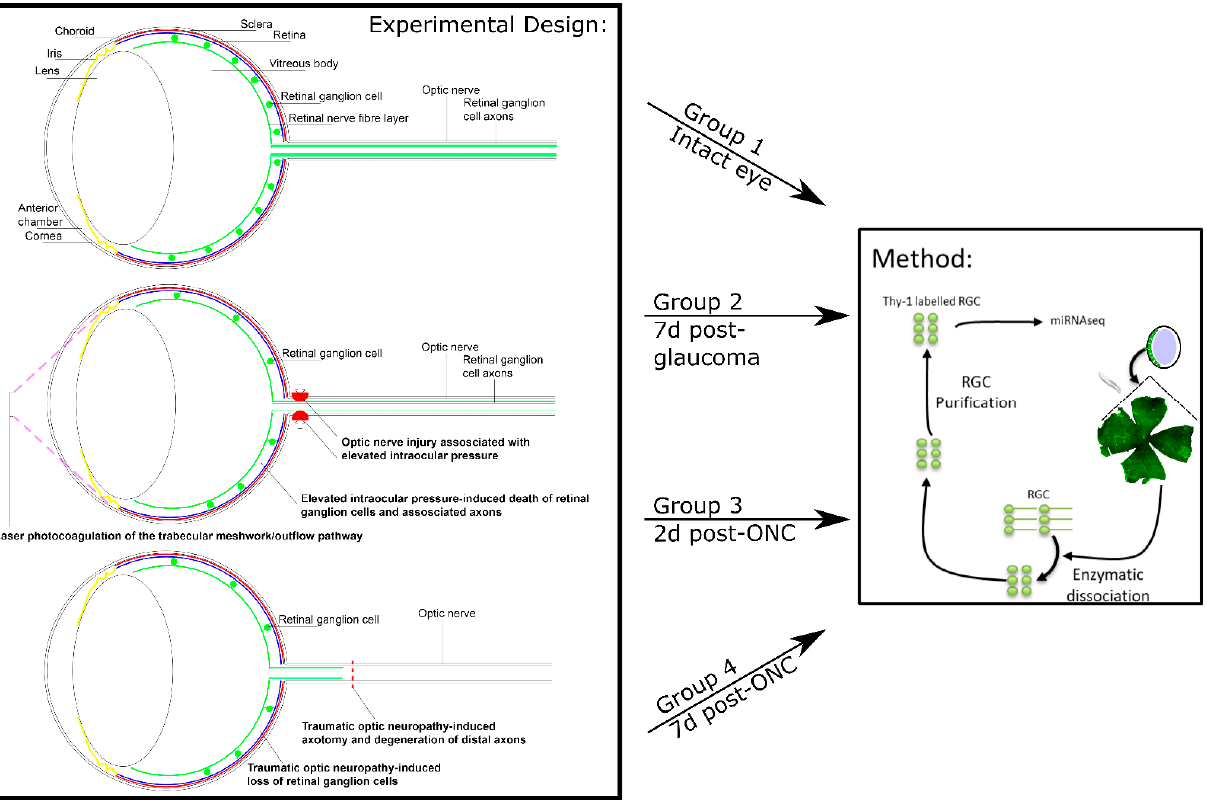
Figure 1. The experimental design of the present study. Timeline and groupings of the present study, detailing the models used and the method of RGC purification.